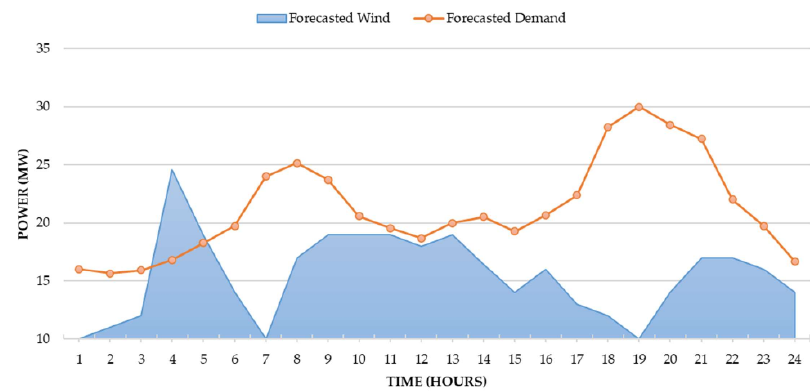
Figure 12. Forecasted wind power and demand with RES’ maximum power output of 20 MW.